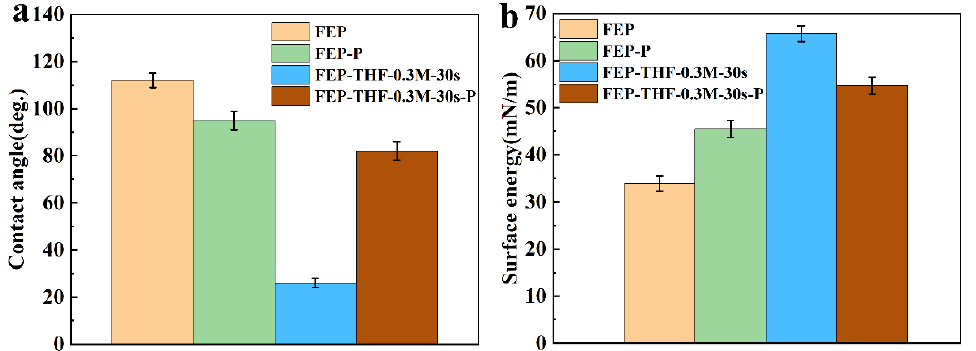
Figure 7. Comparison diagram of the contact angle and surface energy of FEP films under different activation conditions of the sodium naphthalene-THF system: ( a ) contact angle, ( b ) surface energy.